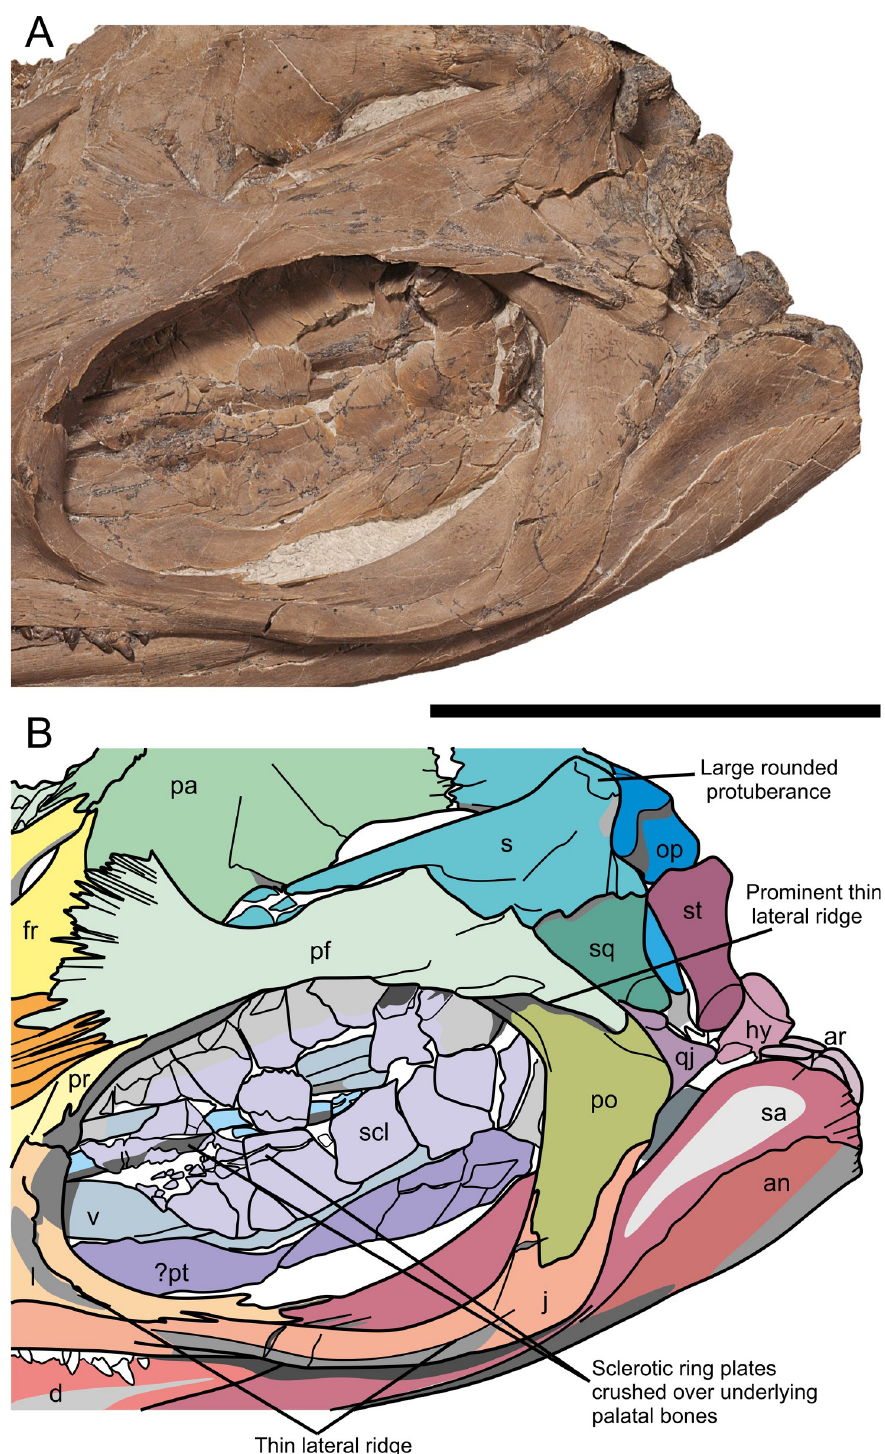
Fig 9. Posteroventral portion of the skull of Thalassodraco etchesi MJML K 1885. A, photograph of the posteroventral portion of the skull. B, annotated interpretation. See caption for Fig 7 for abbreviations. Scale bar 50